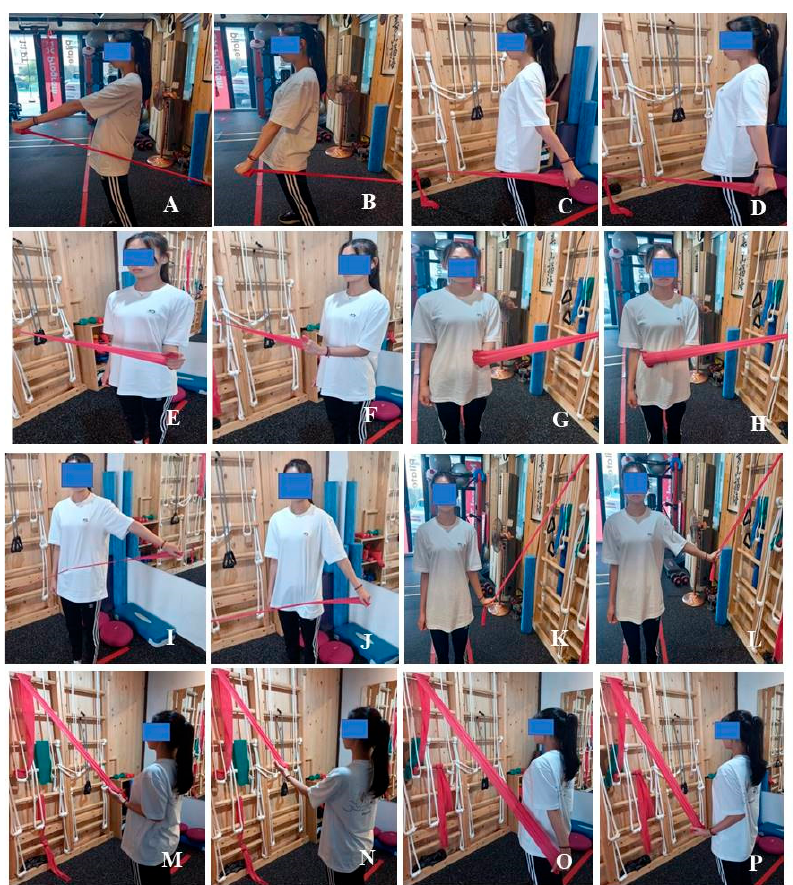
Figure 2. Exercise intervention: ( A ) forward flexion with concentric contraction; ( B ) forward flexion with eccentric contraction; ( C ) extension with concentric contraction; ( D ) extension with eccentric contraction; ( E ) external rotation with concentric contraction; ( F ) external rotation with eccentric contraction; ( G ) internal rotation with concentric contraction; ( H ) internal rotation with eccentric contraction; ( I ) abduction with concentric contraction; ( J ) abduction with eccentric contraction; ( K ) adduction with concentric contraction; ( L ) adduction with eccentric contraction; ( M ) rowing with concentric contraction; ( N ) rowing with eccentric contraction; ( O ) rowing plus with concentric contraction; ( P ) rowing plus with eccentric